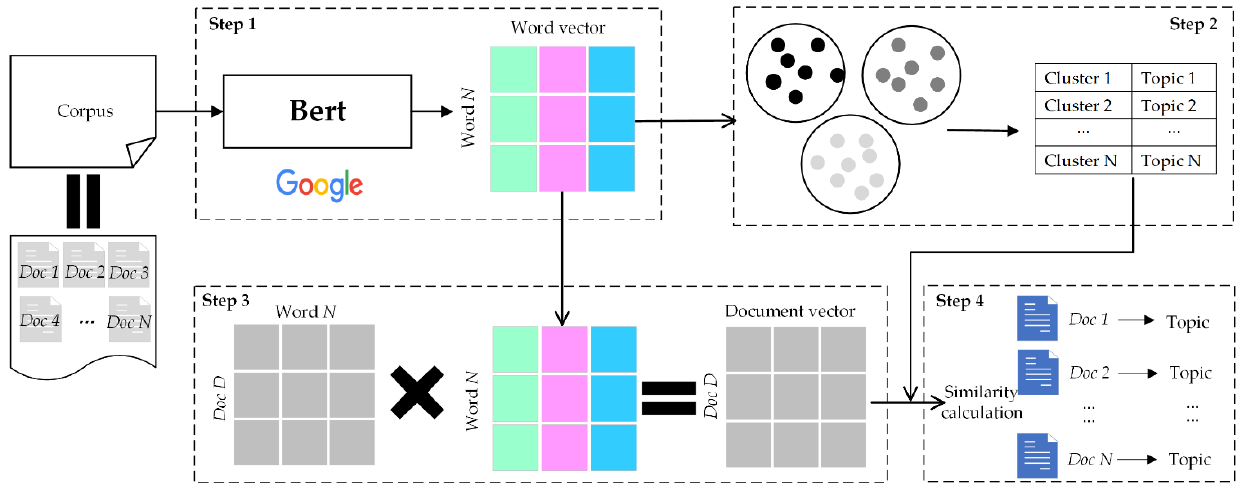
Figure 3. Document topic generation method.